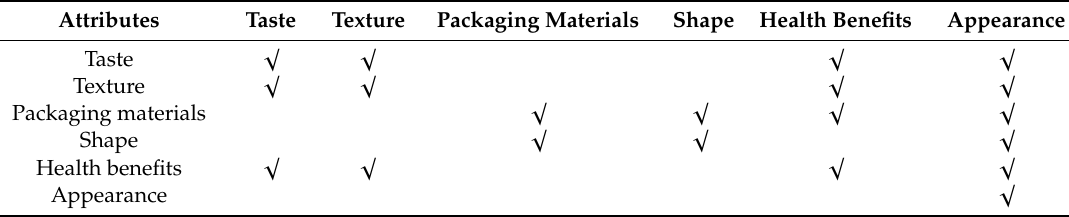
Table 10. Relationships between